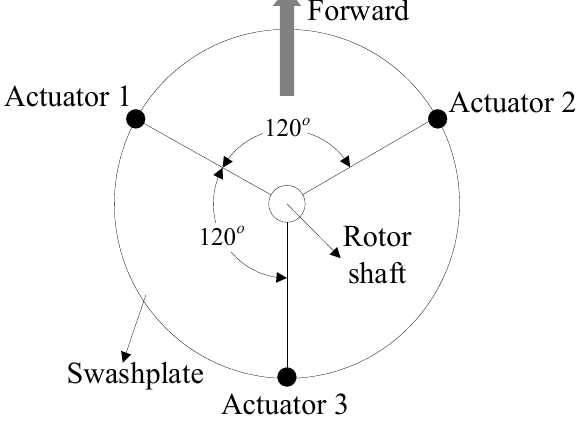
Figure 3. Swashplate structure.